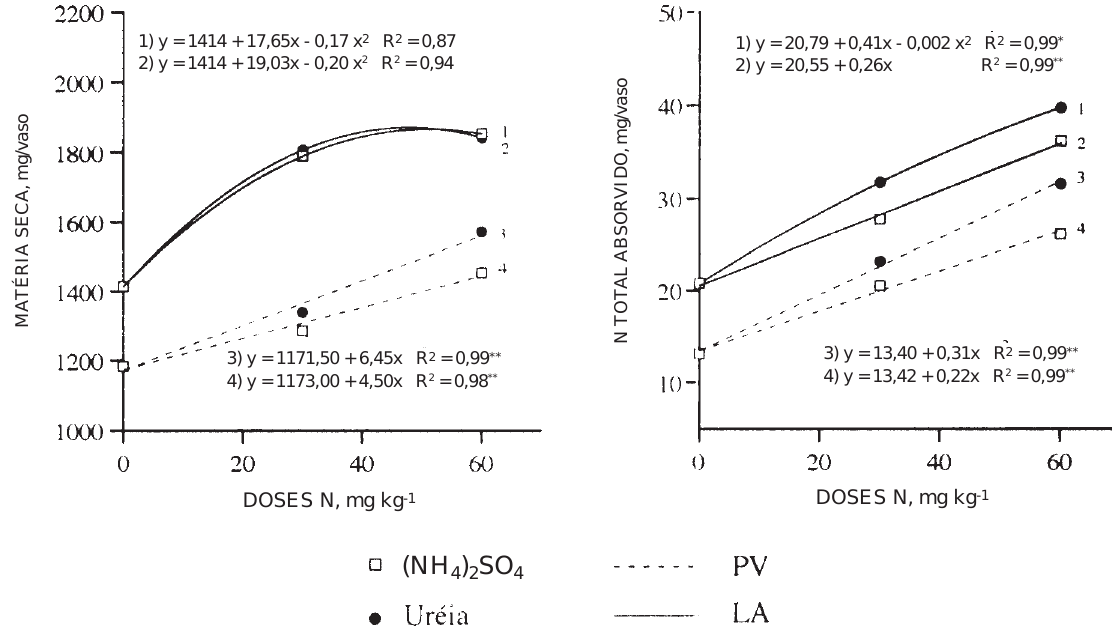
Figura 1. Distribuição de N proveniente do solo e do fertilizante na parte aérea do “rye-grass” em dois solos da Amazônia